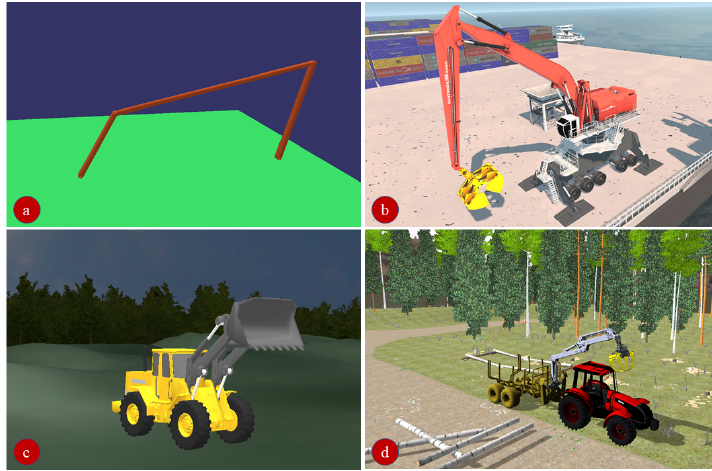
Figure 1. Simulation models with their working environments: ( a ) Four-bar mechanism. ( b ) Material handler. ( c ) Wheel loader. ( d ) Forestry